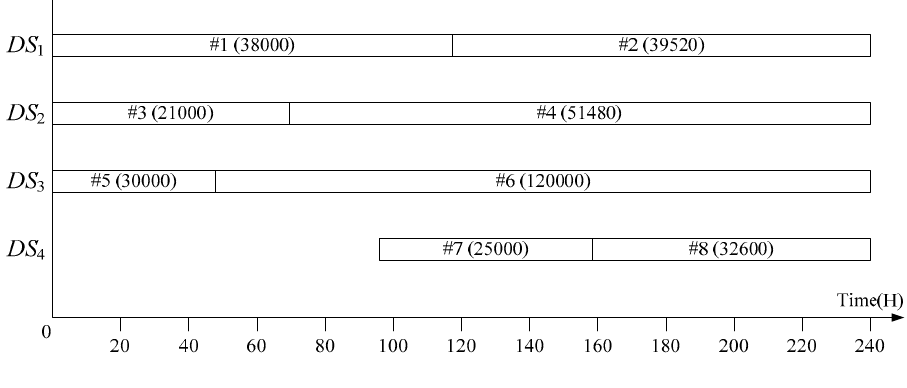
Figure 9. Refining schedule for the case study.